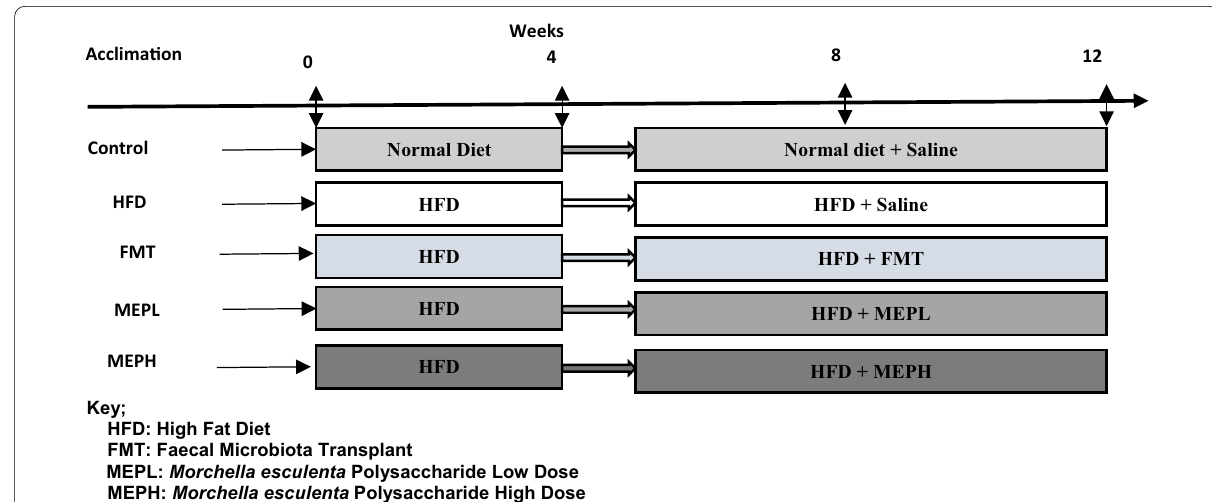
Fig. 1 Experimental plan. Mice were divided into five groups (n microbiota transplant (FMT group), low dose of MEP (MEPL group), and high dose of MEP